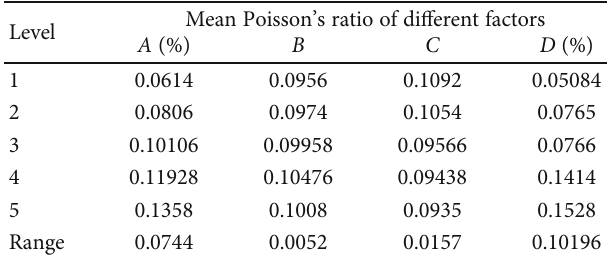
Table 7: The range analysis of Poisson ’ s